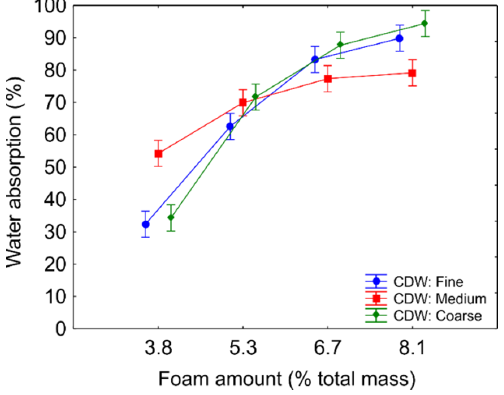
Figure 6. Water absorption as a function of FA for different CDW granulometries.